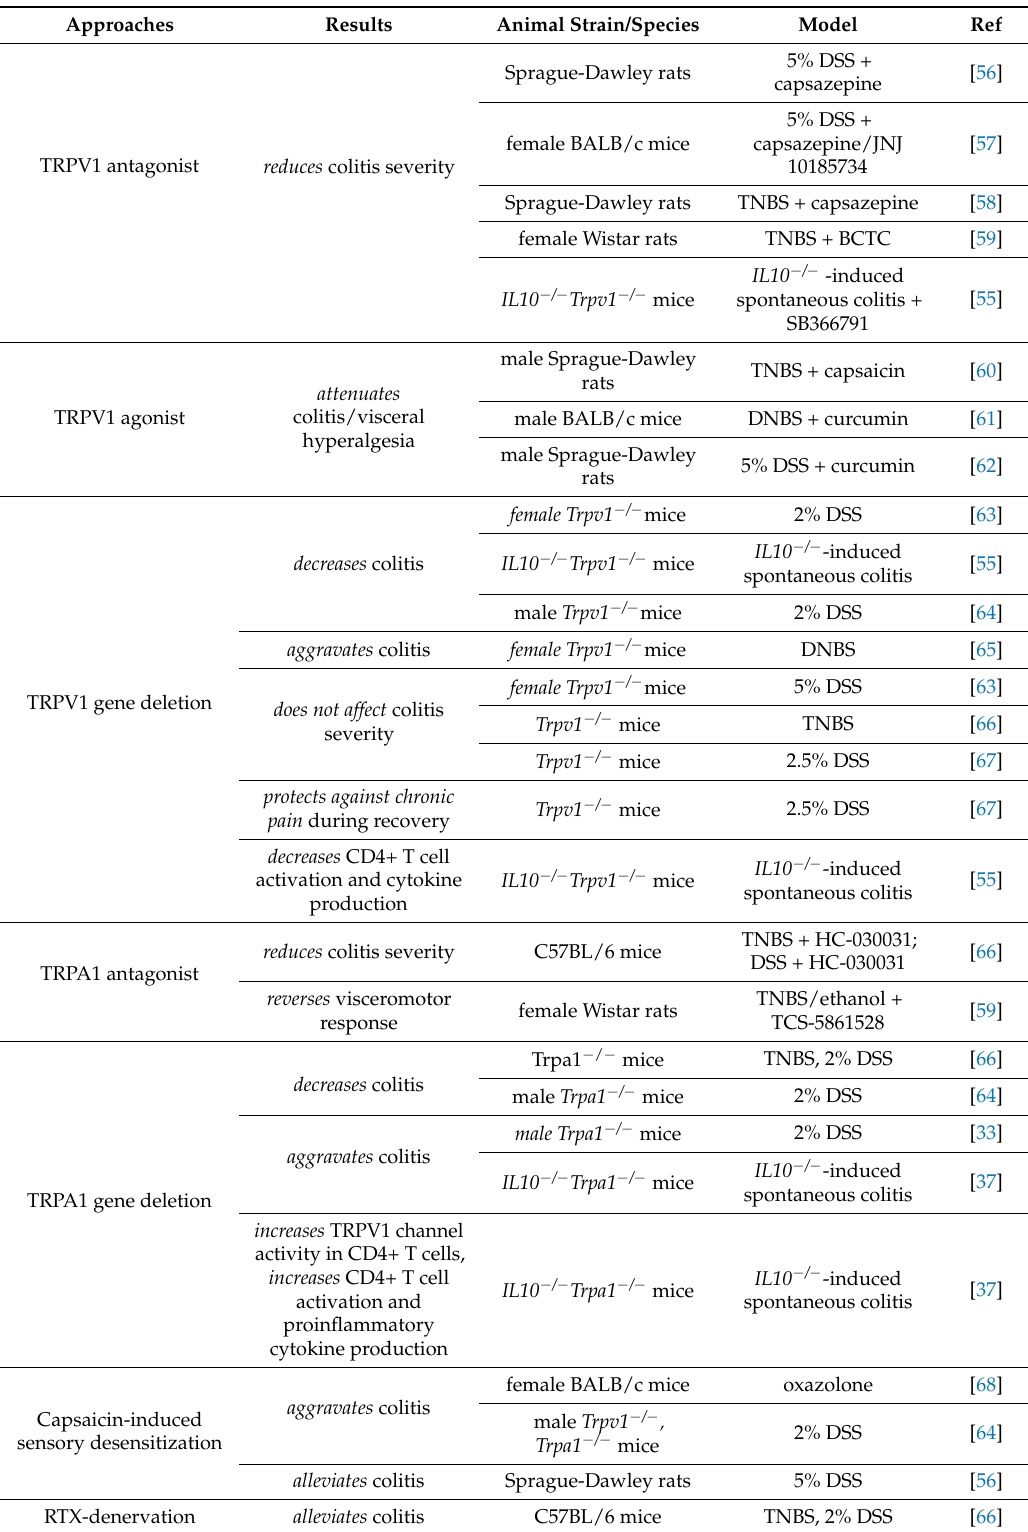
Table 5. Role of TRPV1 and TRPA1 in animal models of colitis ( Trpv1 − / − , Trpa1 − / − gene deleted mice were bred on C57BL/6